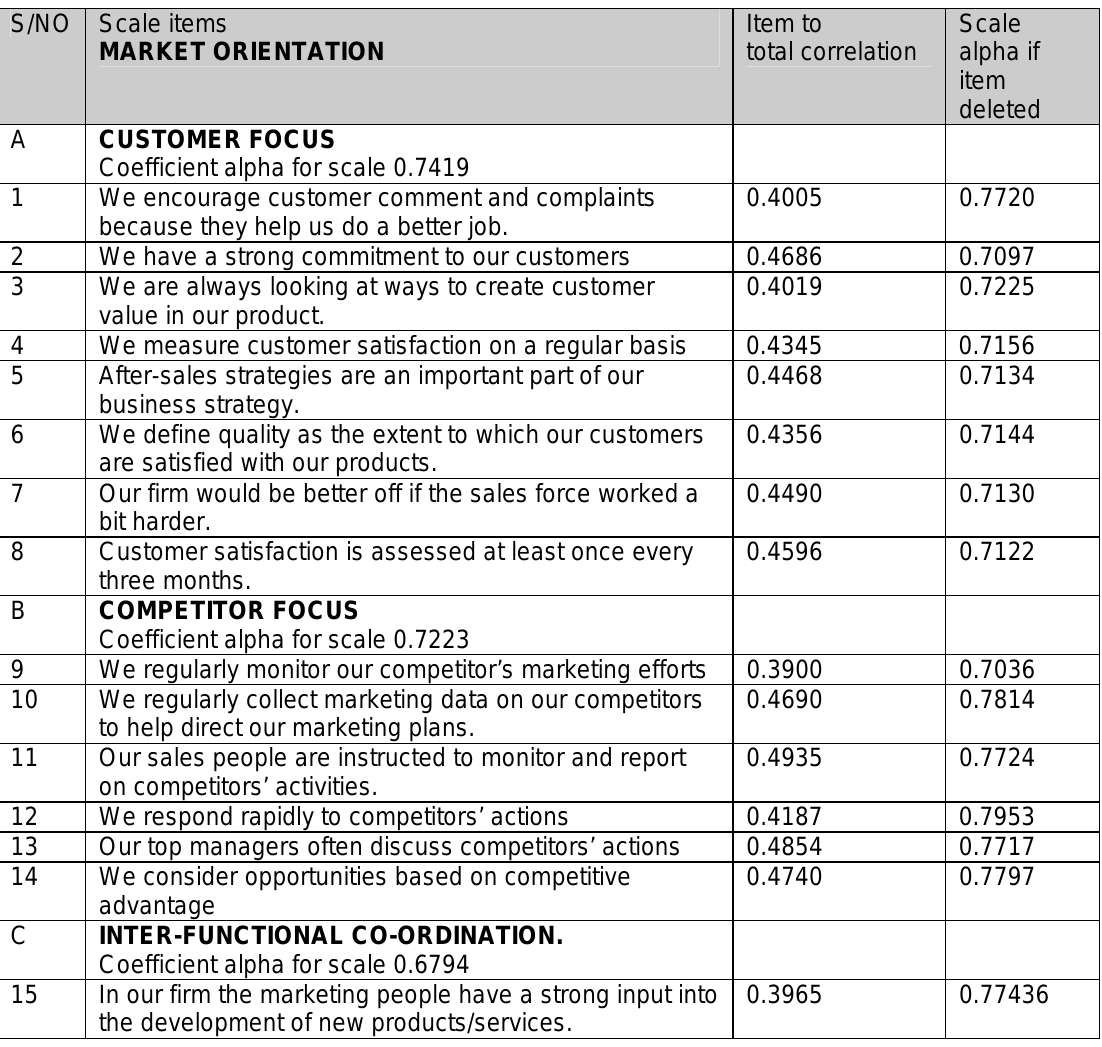
Table I: Scale Reliability of Market Orientation